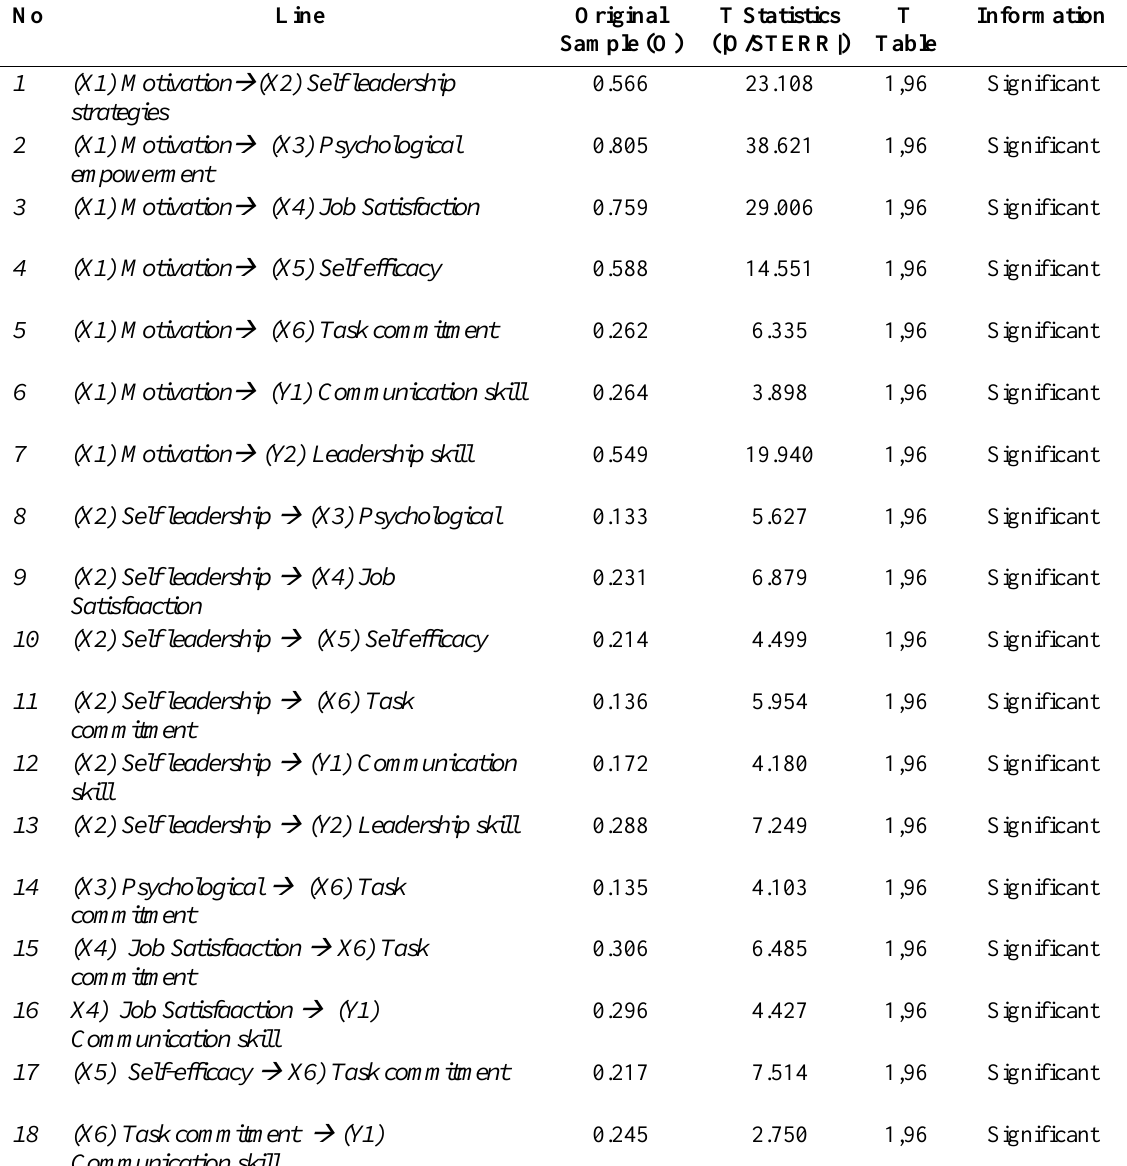
Tabel 2. T-Test Result of the Exogenous Latent Variable to the Endogenous variables and Line Coefficient Parameters in the Finale Structural Model (Inner Model) No Line Original